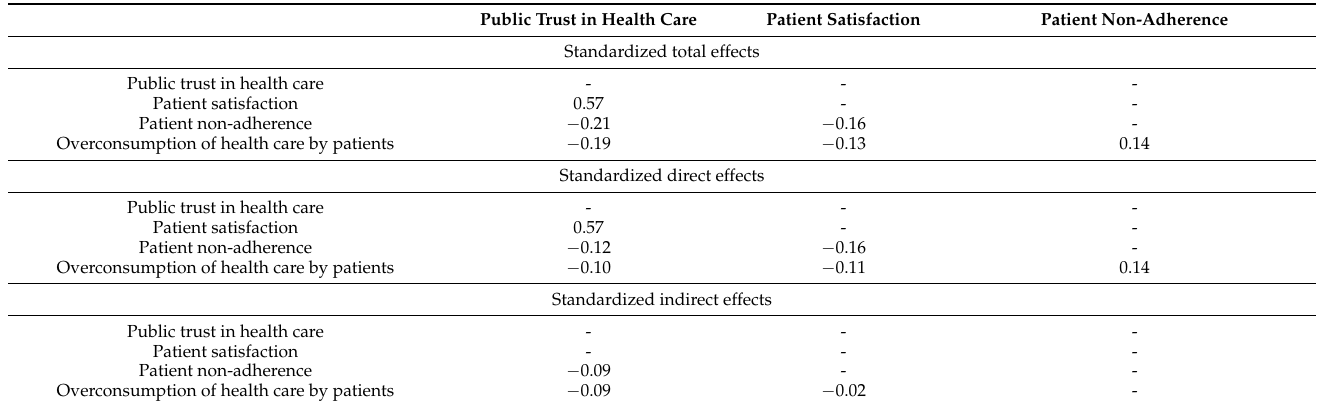
Table 7. Standardized total, indirect, and direct